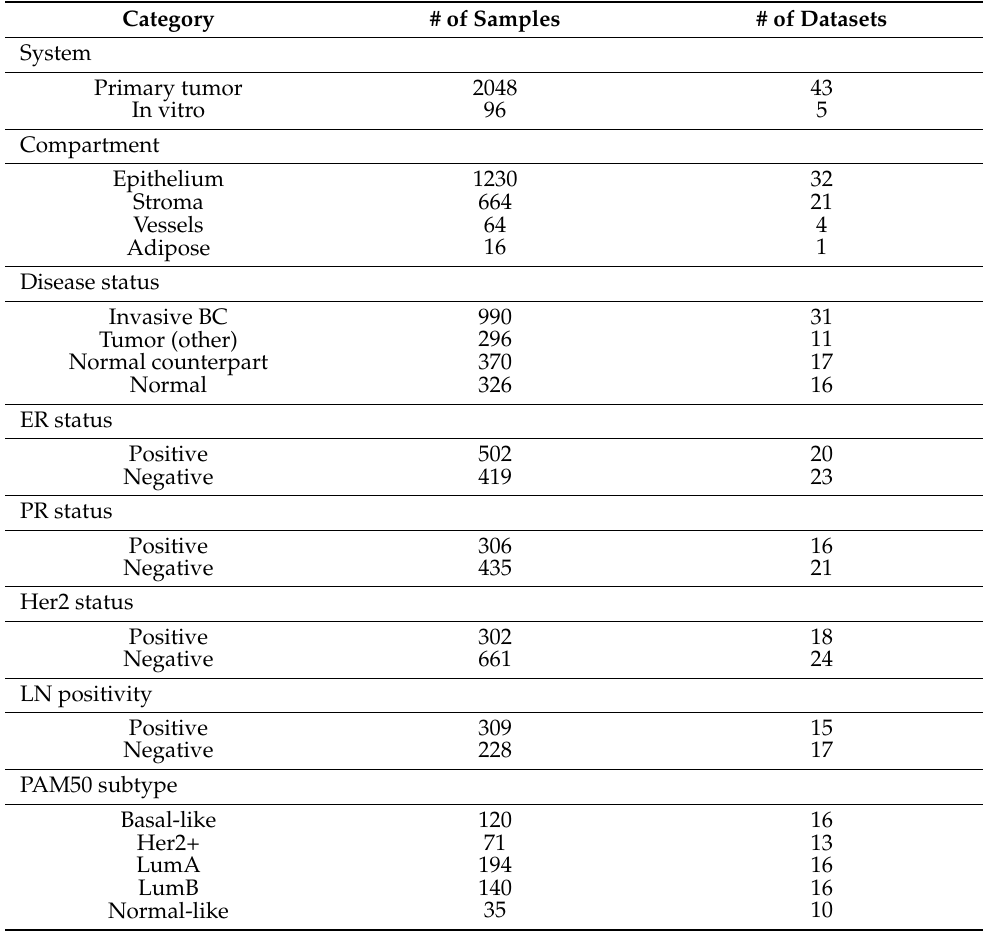
Table 1. Summary of sample features: number of samples derived from primary tumors or in vitro systems and biological/clinical annotations of primary tumor samples. Only the main levels of each factor are shown. For a complete list, refer to Table